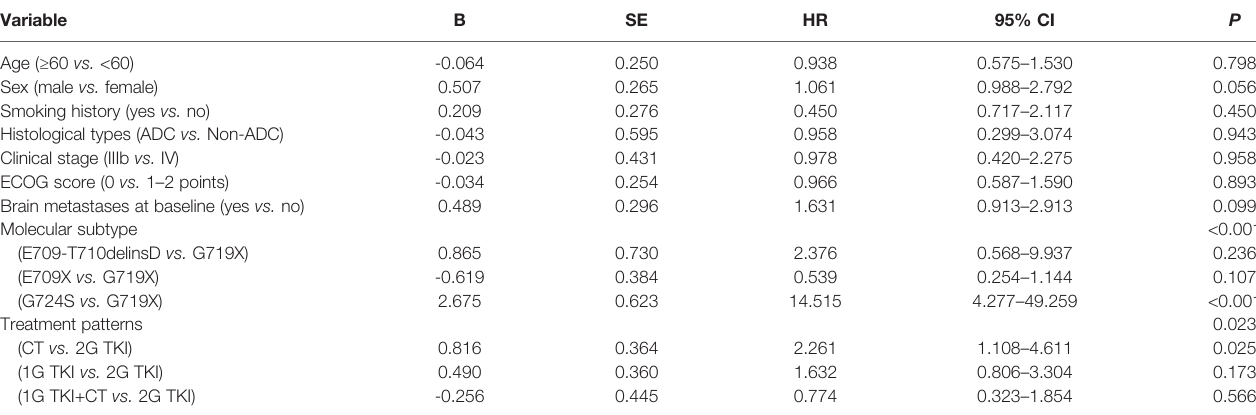
TABLE 4 | Univariate survival analyses for PFS. Variable B